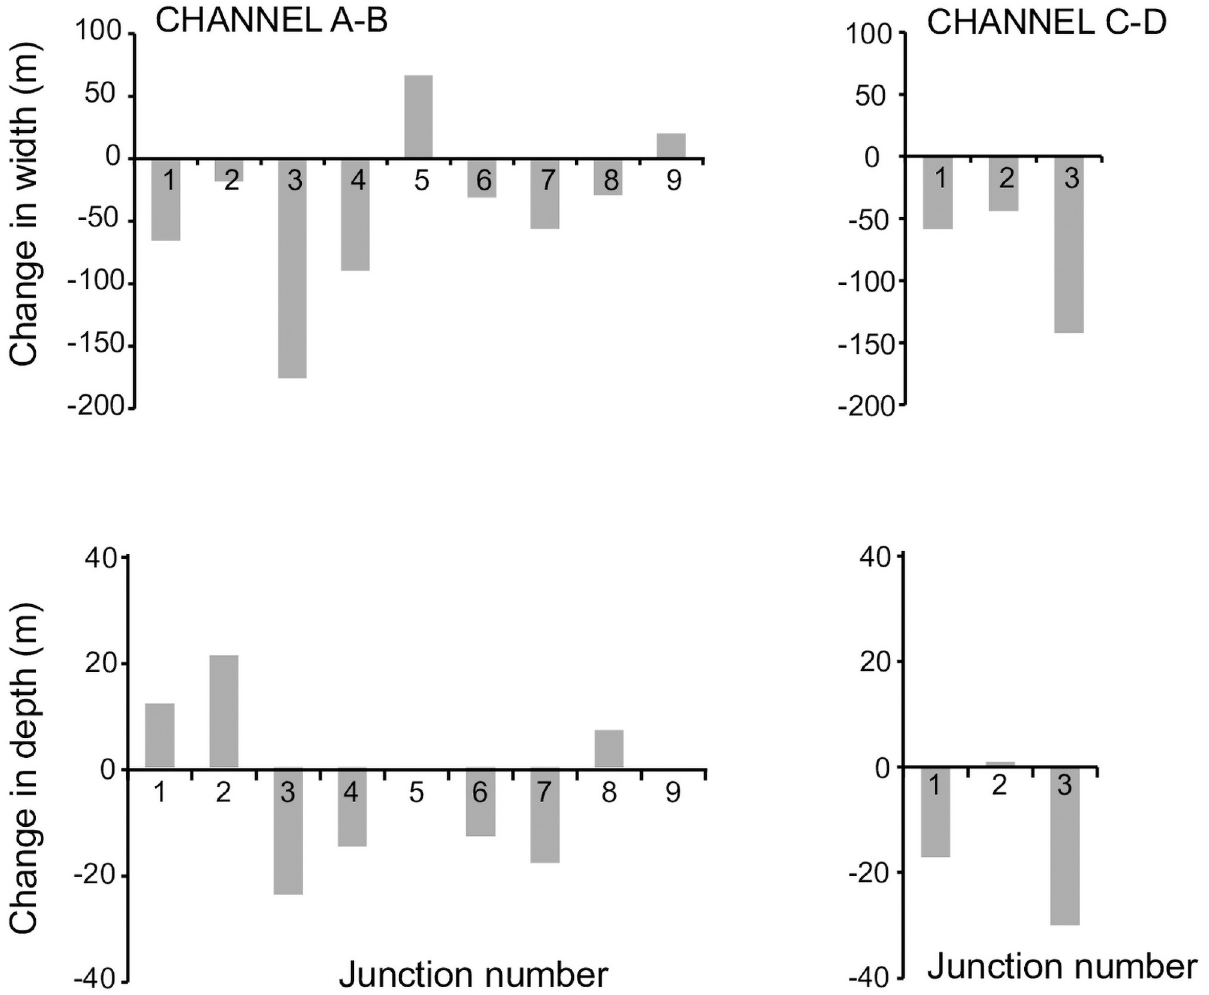
Fig 11. Change in channel width and depth after a junction for channels A-B and C-D in Fig 1. Positive values mean an increase in width and depth. The numbers refer to lateral tributaries discharging in the main trunk (see Fig 1). interpolating parabola is positive and equal to 1.87 10 − 6 m -1 . We therefore ascribe the concave profile to a reduction of erosion rate within the first hundreds of meters upstream of the snout produced by a decrease in transport capacity. The bottom elevation profile of channel C-D is even more concave up, with a second derivative of the interpolating parabola equal to 1.08 10 − 5 m -1 . At tributary junctions, channels show different behaviors. In Fig 11 we plot the difference between the width upstream and downstream of the junction and the channel depth upstream and downstream of the junction (positive values indicate upstream enlargement and deepen- ing). In some cases, the cross section becomes larger upstream of the junction; in other cases, it becomes smaller. In many channels the depth diminishes upstream of a junction (channel A-B junction, 3,4,6,7 channel C-D junction 1,3), while in only three junctions the depth becomes noticeably larger (channel A-B junction 1,2,8). Several channels display negative bot- tom elevation gradients upstream of the junction (channel A-B junction 1,2,4,6 channel C-D junction 1,2,3, Fig 12), but only few experience a switch from positive to negative gradient at